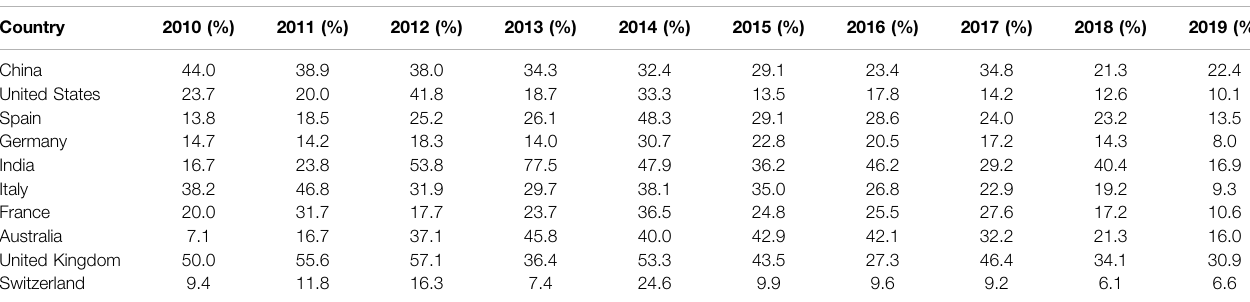
TABLE 3 | Country increment of CSP publications compared to the accumulated from previous year.